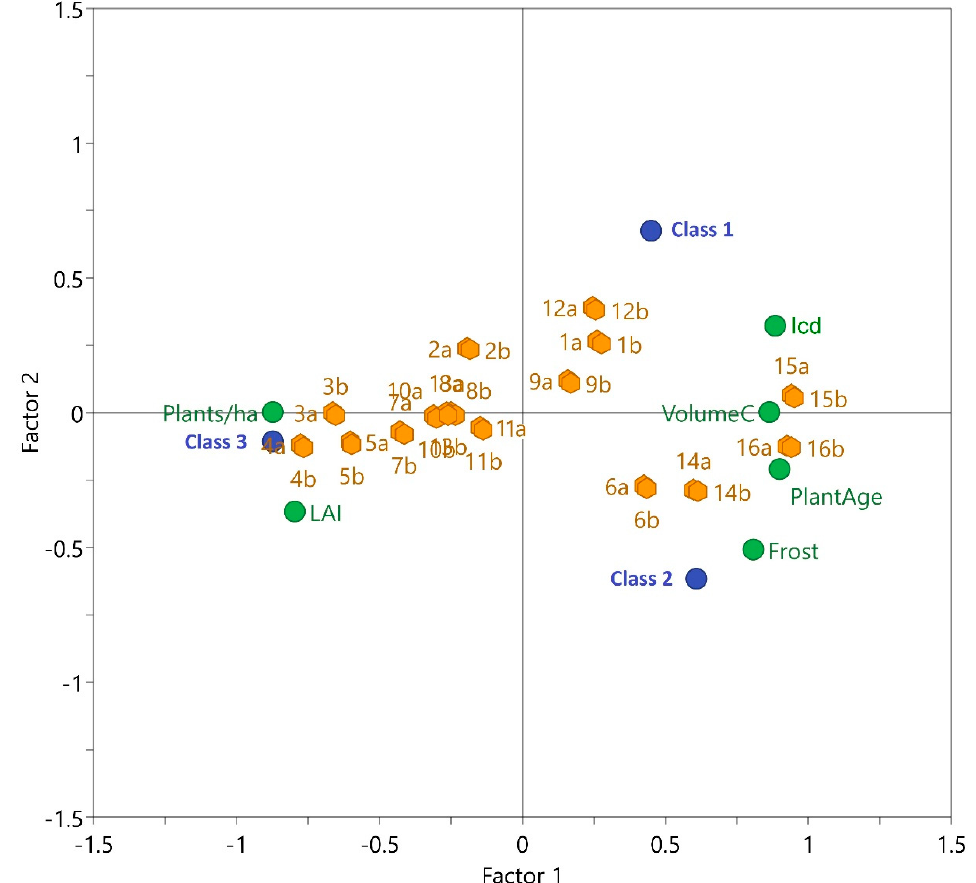
Figure 4. Biplot of the partial least squares discriminant analysis of predisposing factors associated with the incidence of branch canker and dieback in the sixteen orchards prospected in this study in the 2014 and 2015 seasons. Scores (orange hexagons) are shown for the sixteen orchards in both growth seasons (32 observations; 2014 season (a); 2015 season (b)). Loadings are shown in green circles. Factors = 3; R 2 Ycum = 75.4%; Q 2 Ycum = 64.5%. Class = 3; Class 1: Icd, VolumeC; Class 2: PlantAge, Frost, H2OETcsu; Class 3: Plants/ha, LAI.